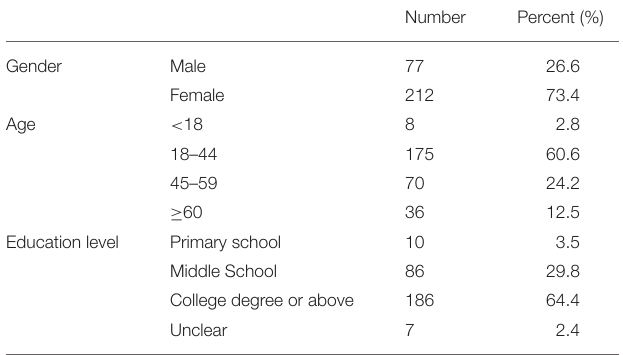
TABLE 1 | Details of the participant characteristics. TABLE 2 | Final scale for tension-type